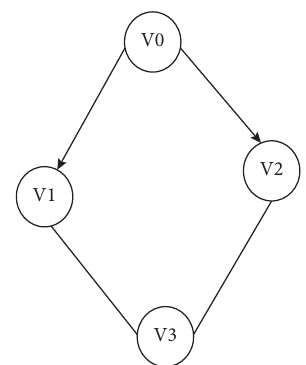
Figure 5: The topology of the leader-following multiagent system under the undirected graph.